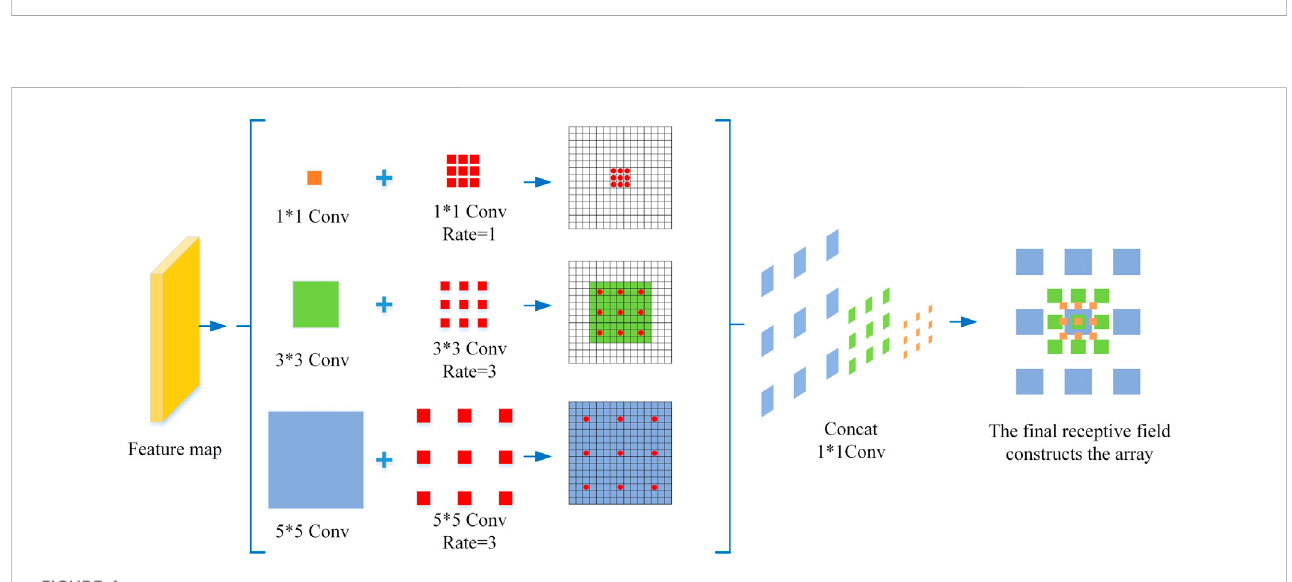
FIGURE 4 Multi-scale receptive fi eld RFB